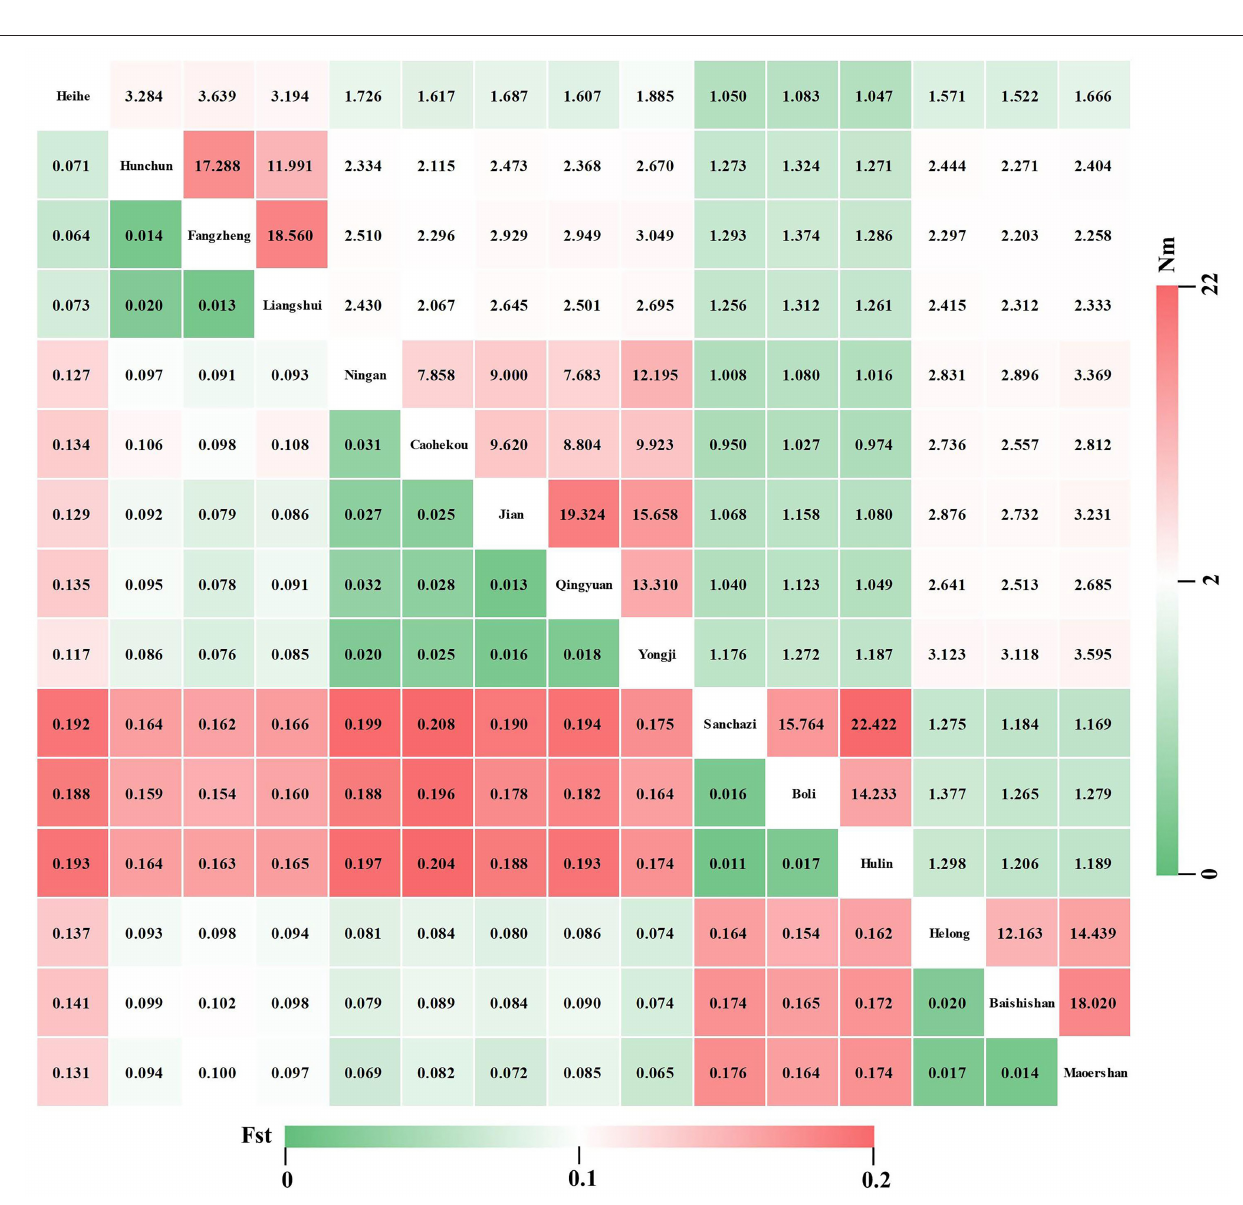
Frontiers in Plant Science |